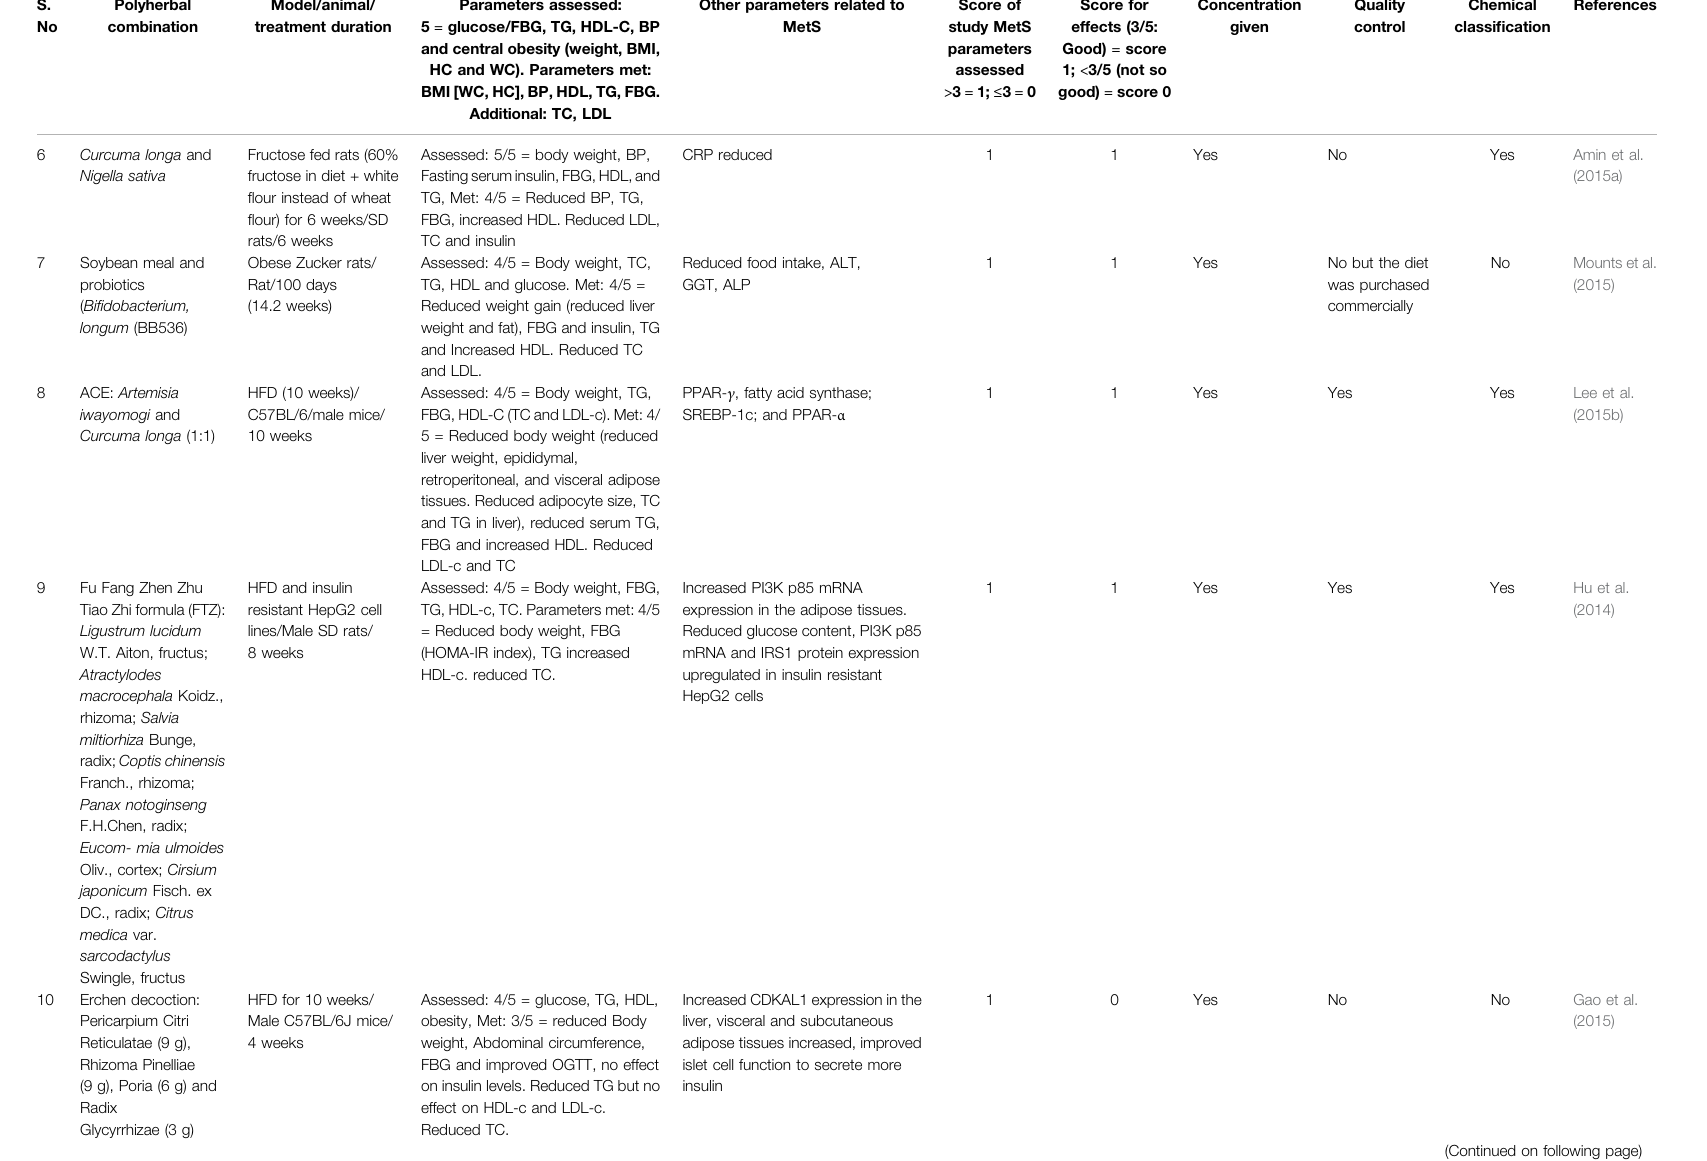
TABLE 3 | ( Continued ) Summary of metanalysis of Poly herbal combinations used in animal-based models of Metabolic